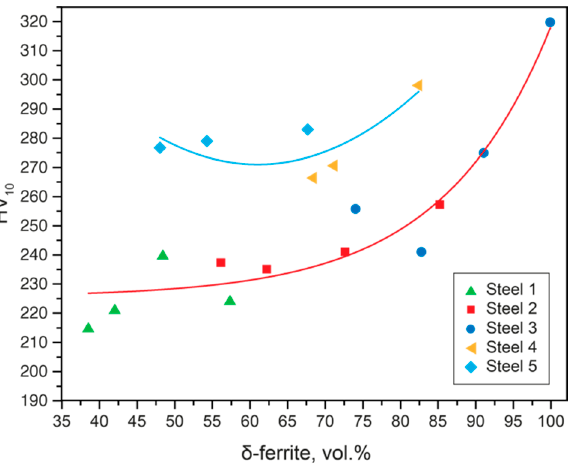
Figure 7. Correlation of hardness HV and the amount of δ -ferrite in steel microstructure. In steels with the same ferrite content but with different PREN values (different degrees of alloying), the hardness was different. The hardness of Steel 3 with 70 vol.% of δ -ferrite is 230 HV, while the higher-alloy Steel 4 has a hardness of 270 HV with the same δ -ferrite content.